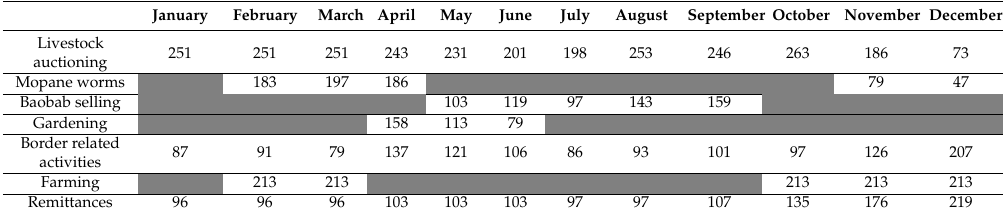
Table 1. 2019 Livelihood options in Beitbridge and corresponding